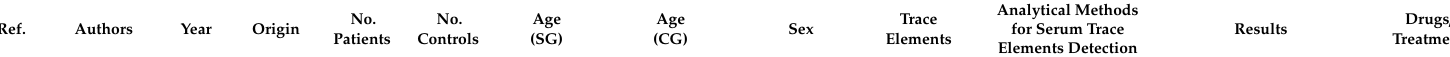
Table 2. The studies about serum trace element concentrations in schizophrenic patients included in the systematic review.